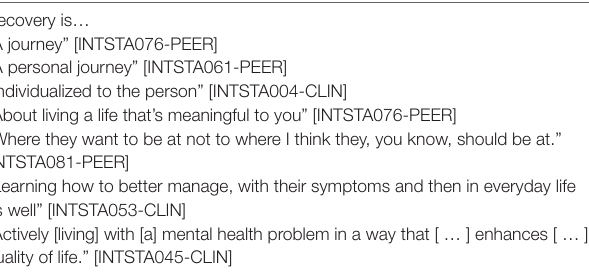
TABLE 3 | Transcript extracts relating to staff concepts of